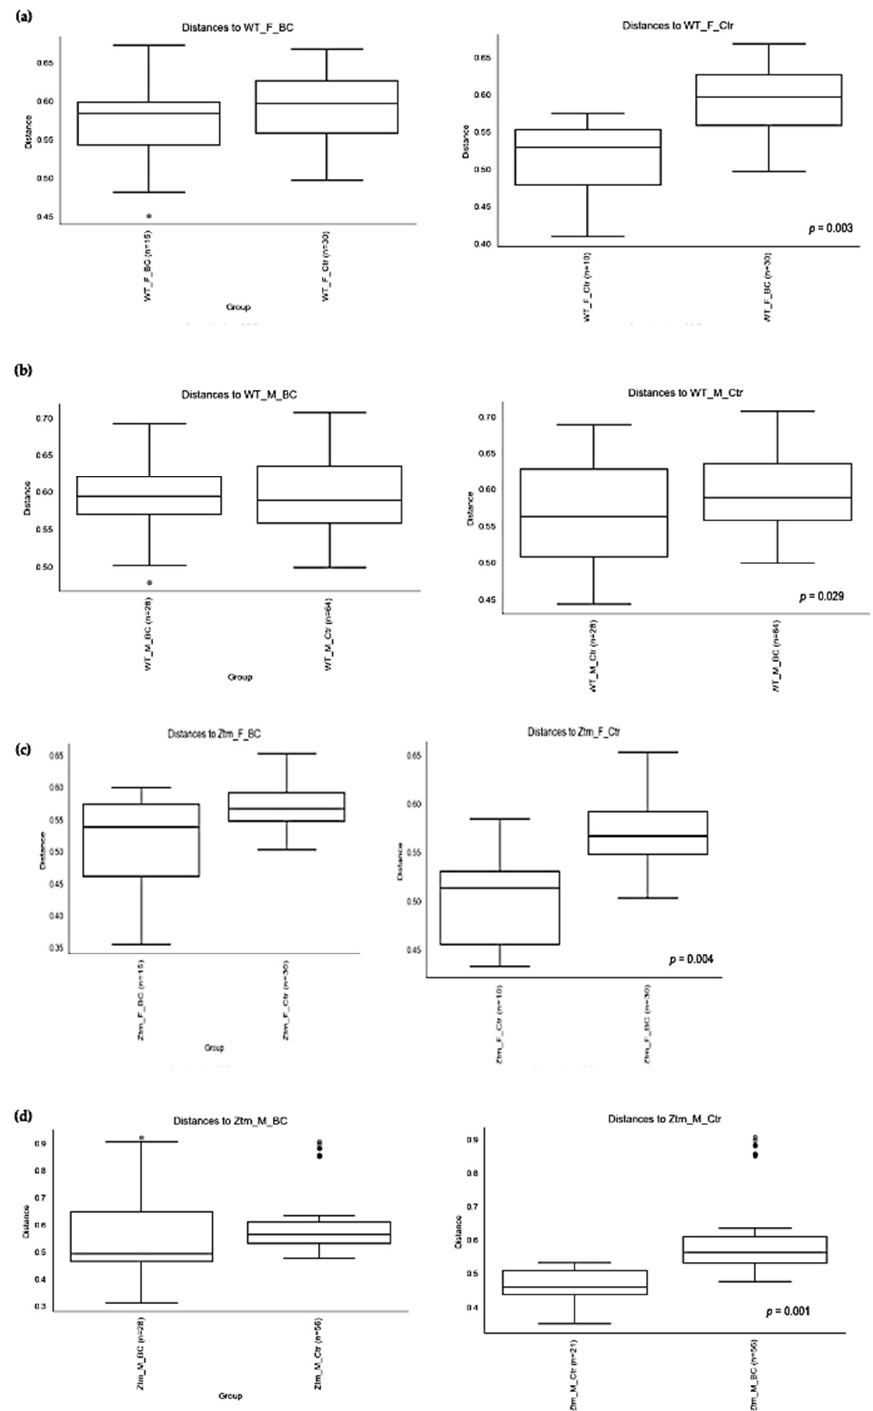
Figure 4. Beta diversity of the intestinal microbial communities between WT f BC and WT f control groups ( a ), WT m BC and WT m control groups ( b ), Ztm f BC and Ztm f control groups ( c ), and Ztm m BC and Ztm m control groups. ( d ) Box plot showing Jaccard distance between groups and within groups, p < 0.05 indicating beta diversity between groups is significant. BC = bovine colostrum treatment; Ctr = control mice; WT = wild-type mice; Ztm = zonulin transgenic mice; f = female; m = male; n = number of mice in a group. p = pairwise PERMANOVA results.